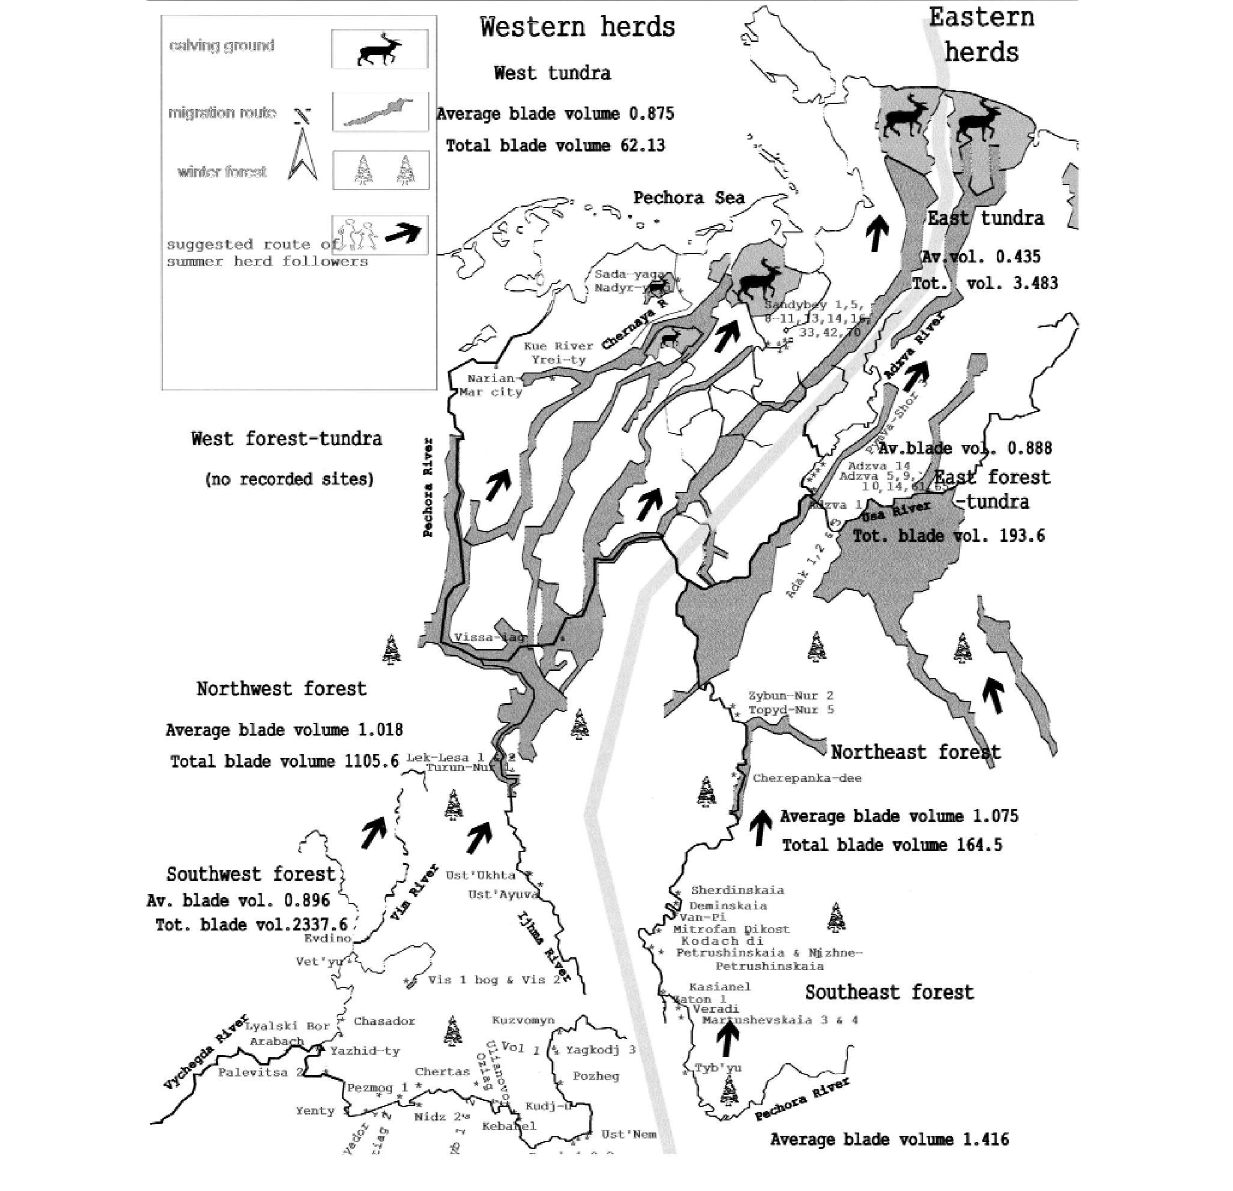
Fig. 10. Mesolithic Eastern and Western reindeer and hunter ranges in far northeast European